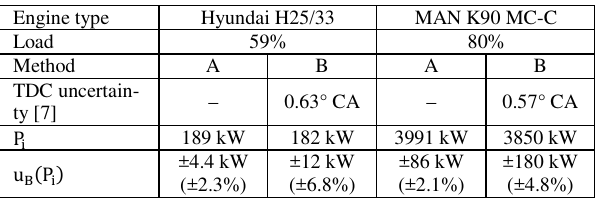
Table 1. Results of indicated work and power calculations with their uncertainties